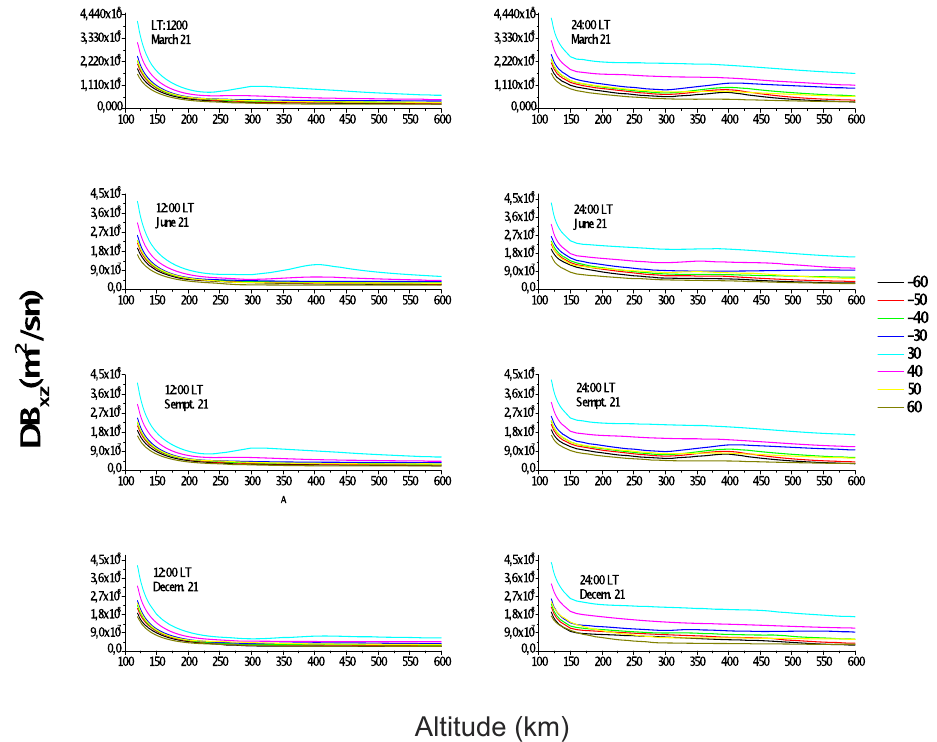
(m 2 /sn) in Equation (10) for mid-latitude in ionospheric plasma. yz